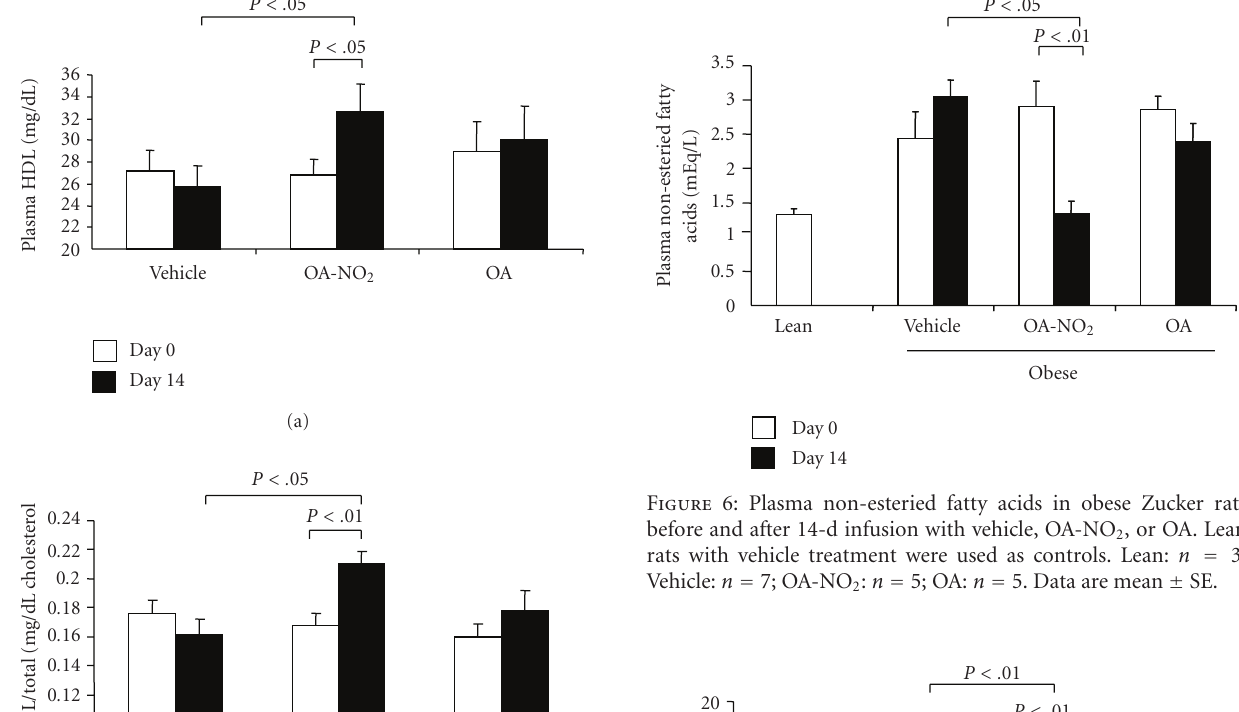
dietary oleic acid in obese Zucker at a dose roughly 500 times higher than that in the present study fails to a ff ect body weight, plasma glucose and lipids despite the amelioration of pancreatic islet disruption [15]. Along this line, the benefits of omega-3 polyunsaturated fatty acid (LC omega-3 PUFA) are also seen with a substantially high dose [16]. More importantly, we found that administration of OA at the same dose and with the same route did not produce any measurable e ff ects on body weight or other metabolic parameters. It appears evident that the beneficial e ff ects of OA-NO 2 observed in obese Zucker rats are derived from the nitration of OA but not the native fatty